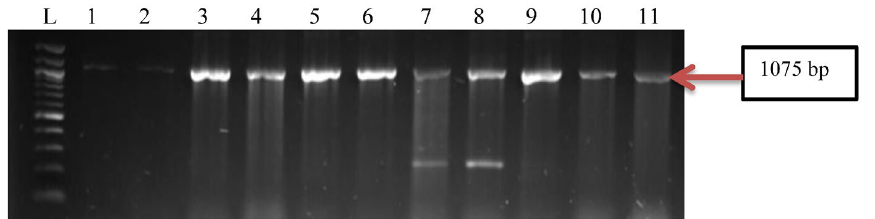
Figure 6. Gel electrophoresis of PCR products of lasA gene among P. aeruginosa representatives isolates recovered from HWW effluent. Lane 1: DNA marker (100 bp). Lane 1–11: positive isolates of lasA gene (1075 bp).